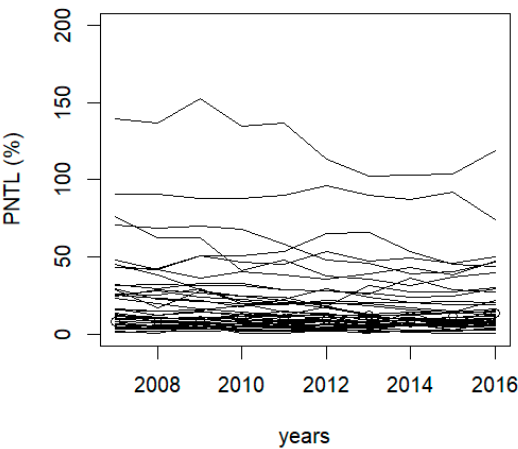
Figure 9. Trajectories of the PNTLs in low voltage (LV) networks [9].